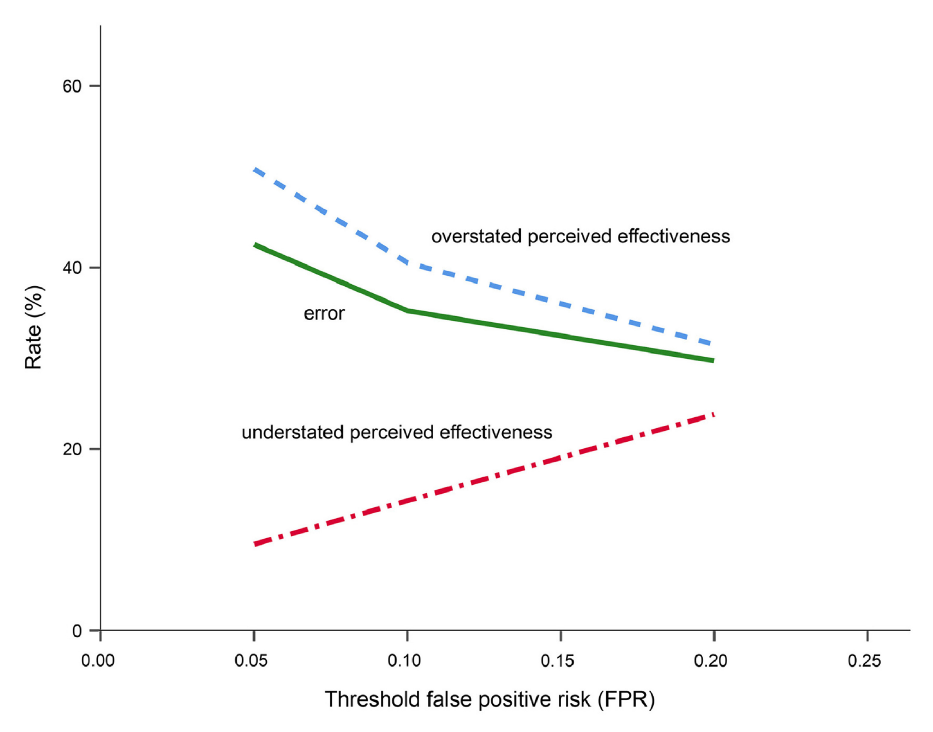
Fig 2. Changes in rates of overstated perceived effectiveness, understated perceived effectiveness and error (misclassification) depending on threshold false positive risk (FPR) values.